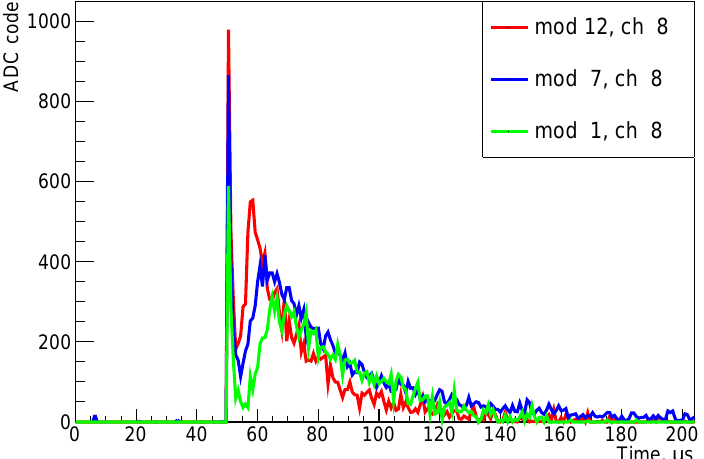
Figure 7. Waveforms of three channels for the unusual bright far-from-thunderstorm event measured by TUS on 28 July